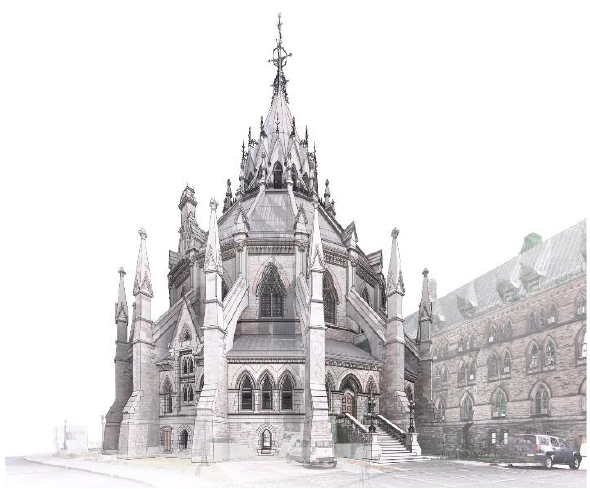
Figure 2. BIM with point cloud of the Library of